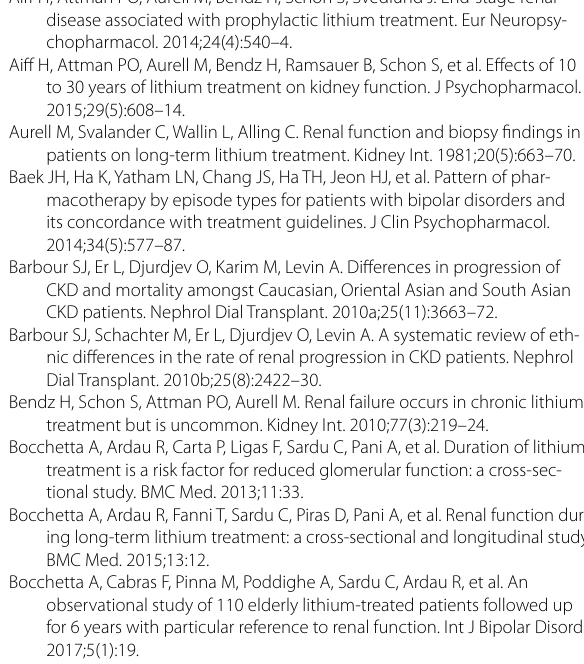
Additional file 1: Table S1. Characteristics of two lithium patients who reached CKD stage 3. Table S2-1. Linear regression predicting yearly eGFR change, conducted as subgroup analysis in patients diagnosed with F20–29. Table S2-2. Linear regression predicting yearly eGFR change, conducted as subgroup analysis in patients diagnosed with F30–31. Table S2-3. Linear regression predicting yearly eGFR change, conducted as subgroup analysis in patients diagnosed with